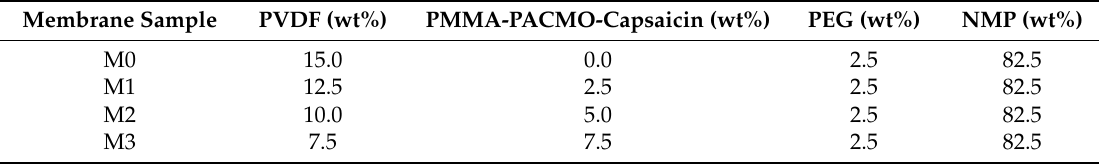
Table 1. The detailed compositions of casting